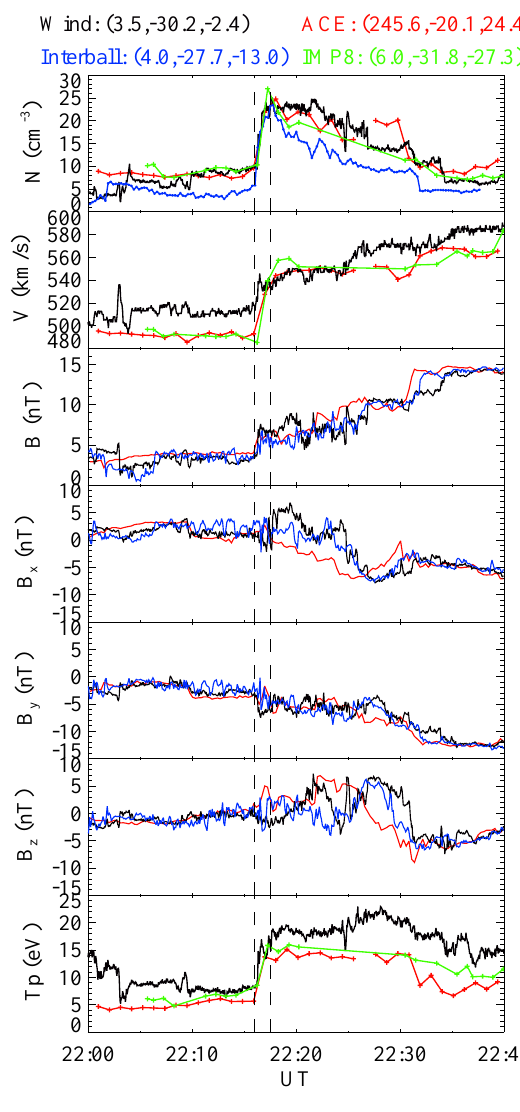
Fig. 1. Solar wind conditions in the GSE coordinate system for the 14 August 2000 event. From the top to the bottom, the panels show the density, speed, IMF and temperature observed by Wind. Avail- able parameters detected by ACE, Interball-1 and IMP 8 are also plotted, shifted by 41, 2.5, and 2min, respectively. On the top of the figure, positions of the four satellites are listed. The vertical dashed lines mark the sudden enhancement of P d